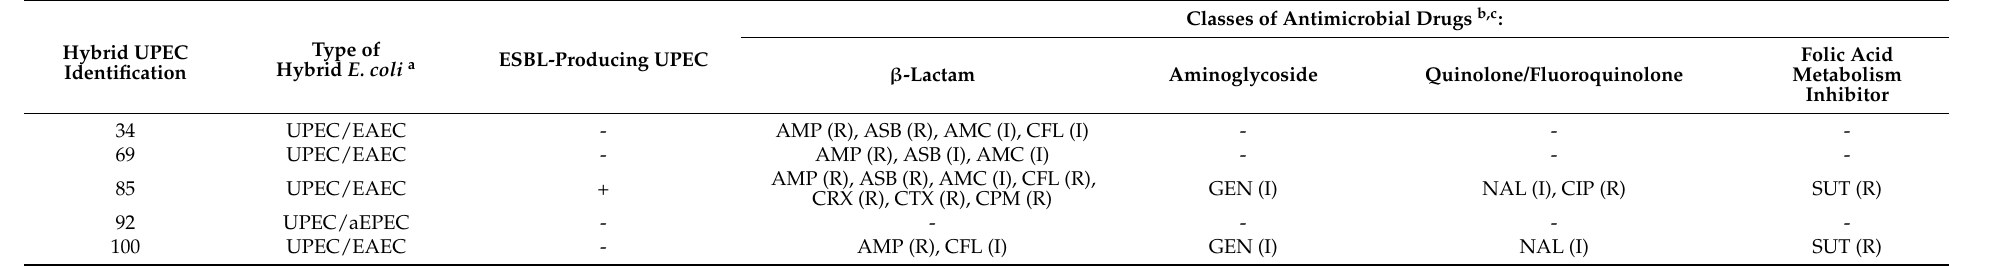
Table 6. Resistance profile of hybrid uropathogenic/diarrheogenic E. coli (UPEC/DEC) isolates identified in the present